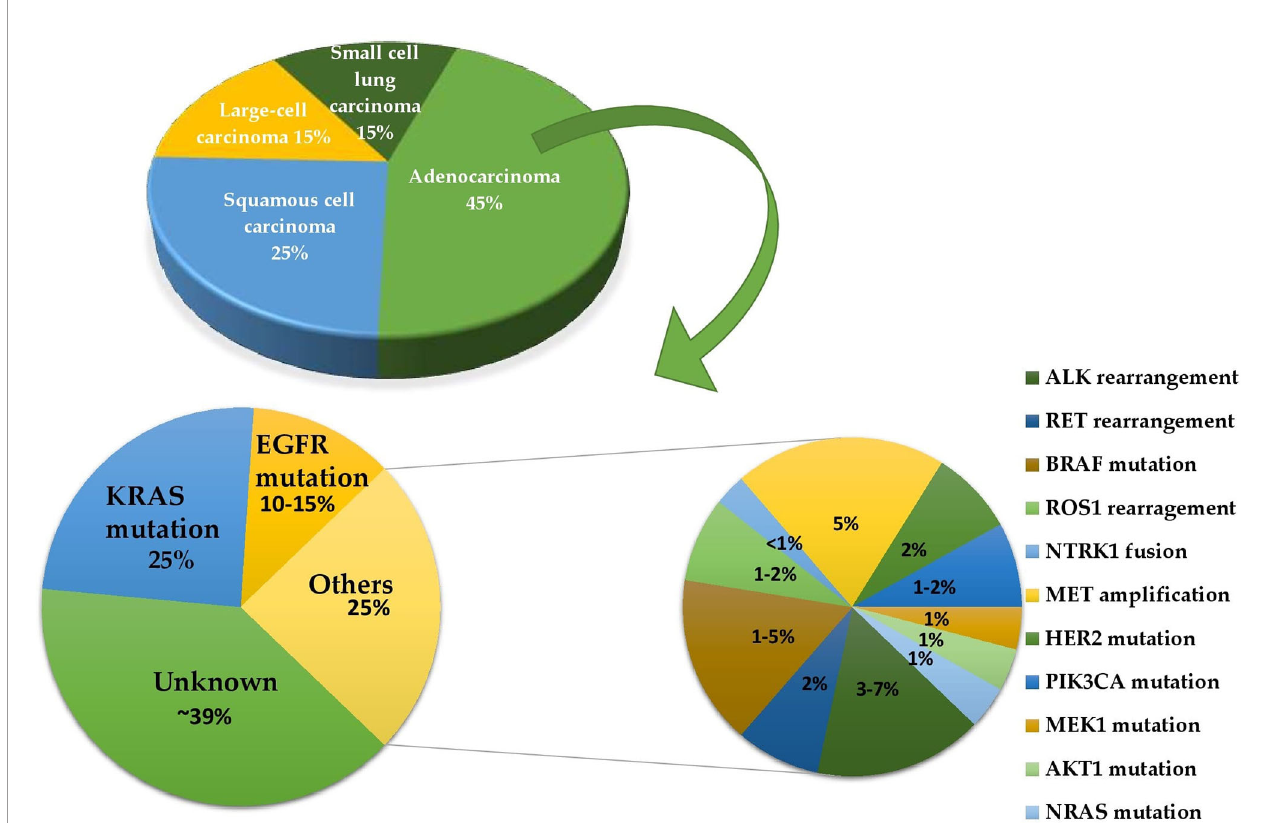
FIGURE 3 | A pie of pie chart determining the frequencies of different driver mutations in lung